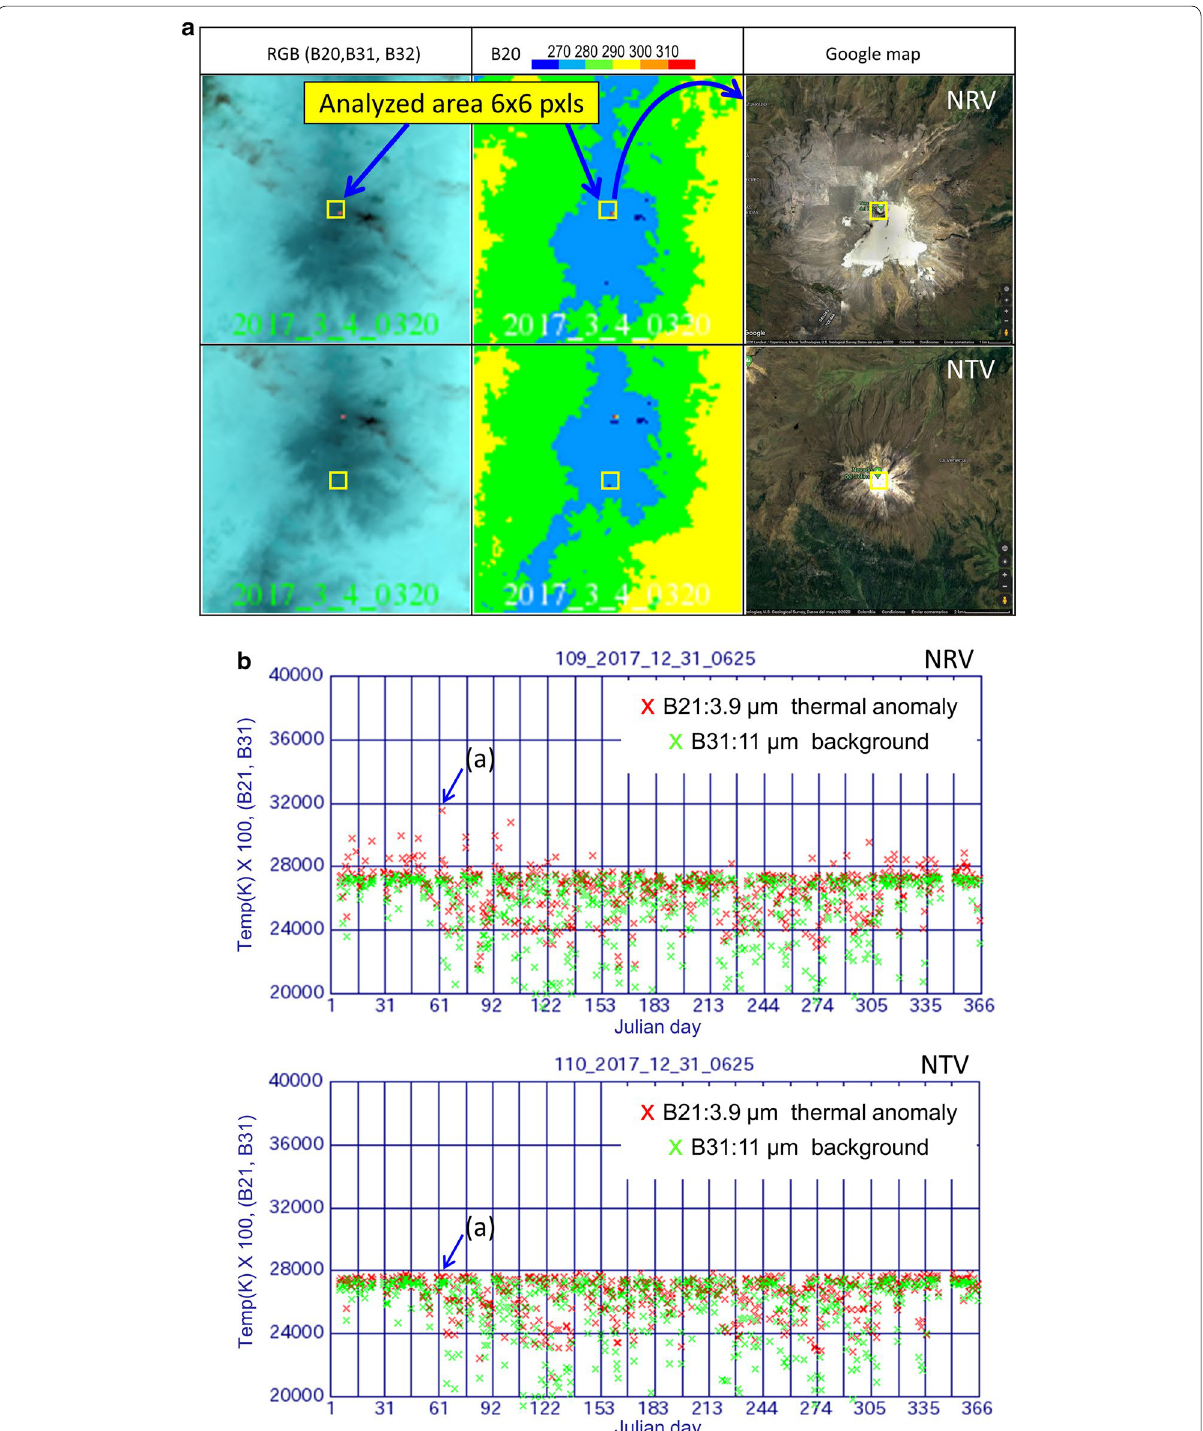
Fig. 3 An example of automatized analyses by REALVOLC. a The target area at NRV for the thermal analyses. b Thermal radiance as a function of Julian day. The radiance of a pixel in the 3.9‑μm band (red crosses) responds to hotspots in the pixel, while that in the 11‑μm band (green crosses) represents the mean temperature. We use the 3.9‑μm band to detect thermal anomaly and the 11‑μm band to estimate the background